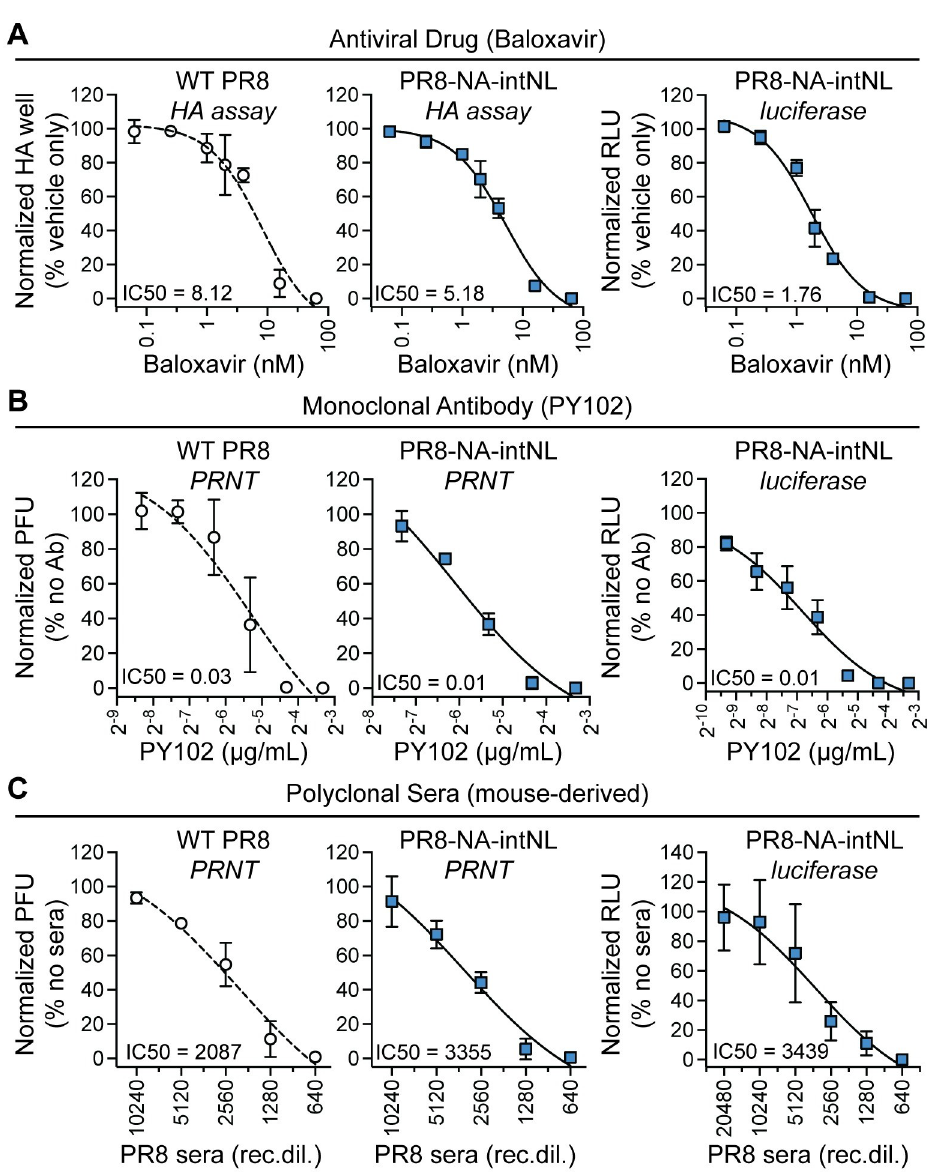
Fig 4. IAVs harboring introns with luciferase genes can be used to evaluate antibodies and antiviral compounds. (A) Virus levels from Baloxavir treated WT PR8 (left) and PR8-NA-intNL (middle) virus infections (MOI = 0.05, multicycle, 48h) measured using HA assays and luciferase levels from Baloxavir treated PR8-NA-intNL (right) virus infections (MOI = 0.01, multicycle, 24h) on MDCK cells (mean with SD, n = 3 independent experiments, nonlinear regression dose-response curve). Normalized to vehicle-treated, infected controls. (B) Virus levels from PY102 anti-H1 antibody pre-incubated WT PR8 (left) and PR8-NA-intNL (middle) virus infections (40 virions/well) measured using PRNTs and luciferase levels from PY102 anti-PR8 HA antibody pre-incubated PR8-NA-intNL (right) virus infections (MOI = 0.001, multicycle, 24h) on MDCK cells (mean with SD, n = 3 independent experiments, nonlinear regression dose-response curve). Normalized to PBS pre-incubated controls. PRNTs, plaque reduction neutralization tests. (C) Virus levels from anti-PR8 mouse sera pre-incubated WT PR8 (left) and PR8-NA-intNL (middle) virus infections (40 virions/well) measured using PRNTs and luciferase levels from anti-PR8 mouse sera pre-incubated PR8-NA-intNL (right) virus infections (MOI = 0.001, multicycle, 24h) on MDCK cells (mean with SD, n = 3 independent experiments, nonlinear regression dose-response curve). Normalized to PBS pre-incubated controls; rec.dil., reciprocal dilution.